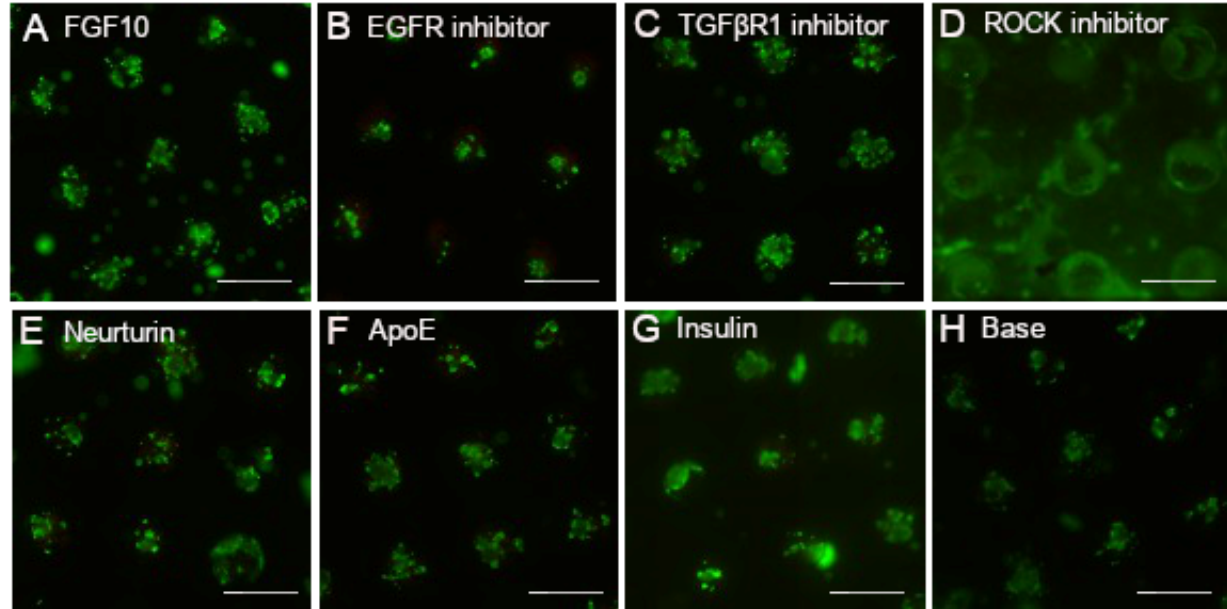
Figure 1. DoE factors are non-toxic to SGm. Cell viability staining using calcein AM (green) for live cells and propidium iodide (red) for dead cells for the individual factors used in the Plackett– Burman DoE: FGF10 ( A ), EGFR inhibitor ( B ), TGF β R1 inhibitor ( C ), ROCK inhibitor ( D ), neurturin ( E ), apolipoprotein E ( F ), and insulin ( G ). Base media is shown for comparison ( H ). Scale bar is 400 µ m. Concentrations used are shown in Table